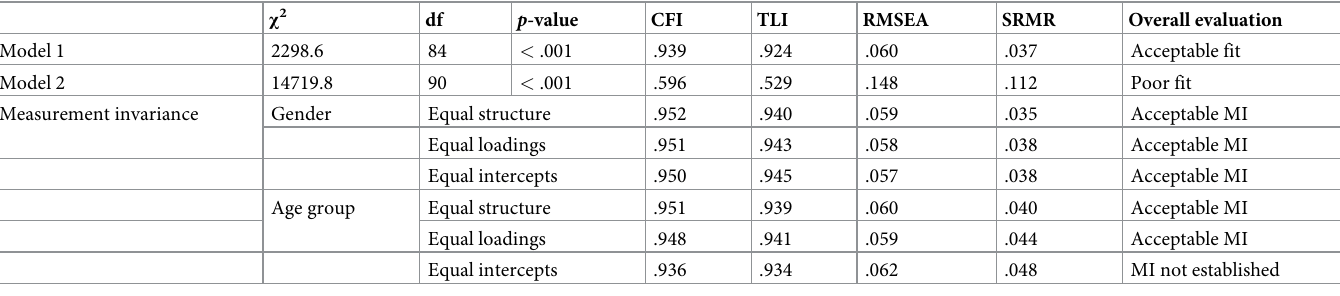
Table 3. Goodness-of-fit indices and evaluations for the specified